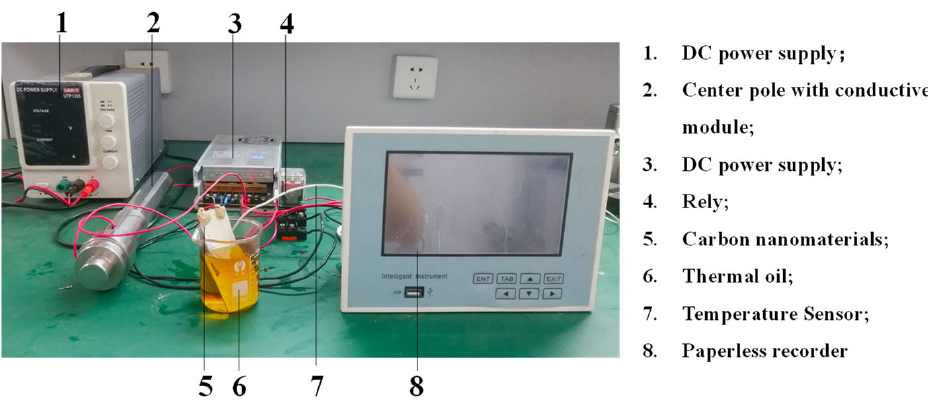
Figure 23. Comparative heating performance experiment.